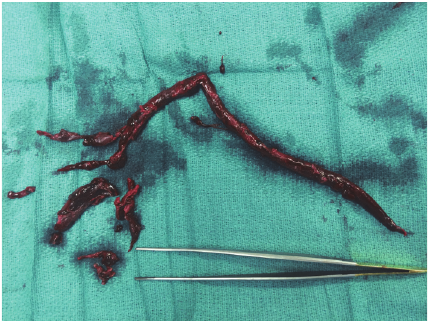
Figure 6: Clot retrieved at